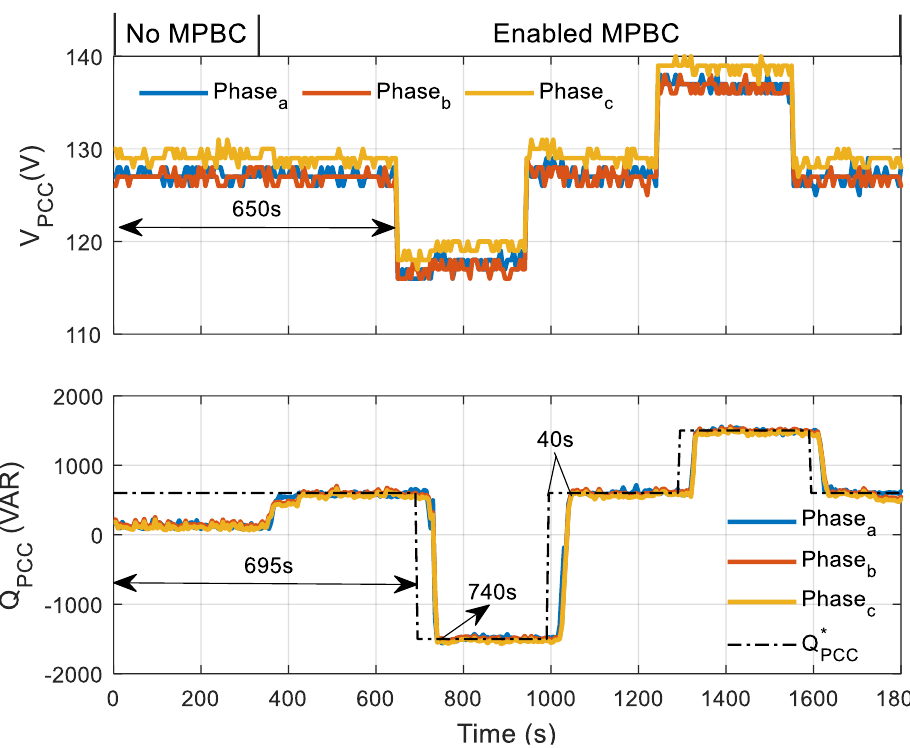
Figure 8. Voltage and PCC reactive power during GOS mode, in terms of voltage variation.